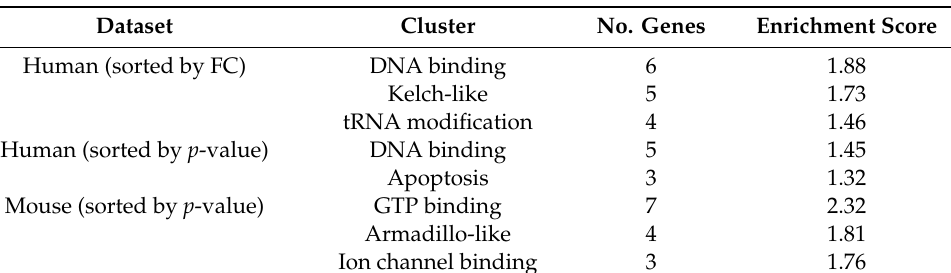
Table 1. Gene network and cluster analysis of di ff erentially expressed genes common to all three comparisons (young versus old; young versus middle aged; middle aged versus old) in both the human and mouse datasets, selected by fold change and by p -value.